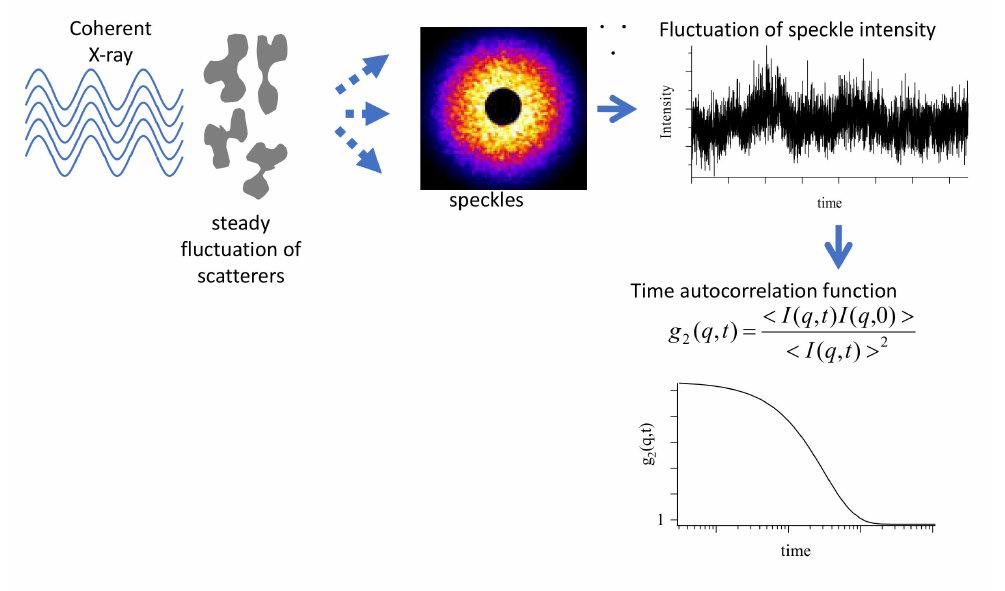
Figure 10. Schematic representation of principle of XPCS